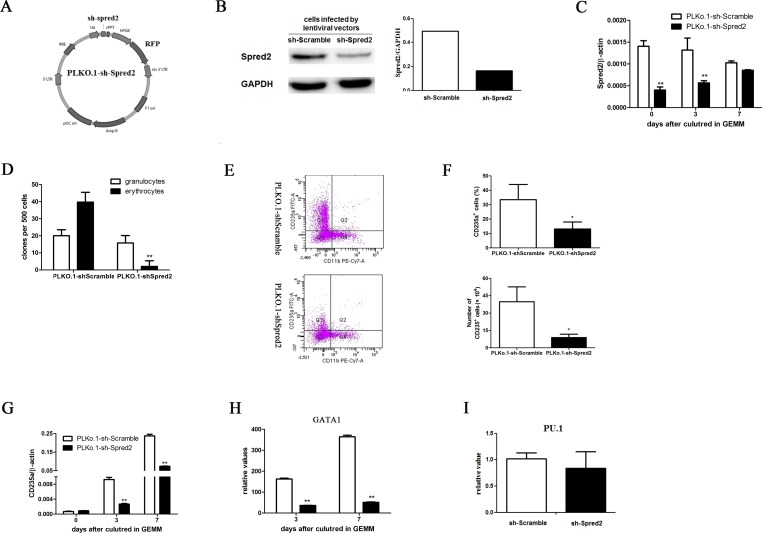
Spred2 interference suppressed the eryhtroid differentiation of human normal bone marrow (NBM) CD34+ cells.The scheme of lentivirus vector with shRNA specifically targeting Spred2, PLKO.1-shSpred2, was shown in A. 48h after transduced with 5 multiplicity of infection (MOI) PLKO.1-shSpred2 or PLKO.1-shScramble, the expression of Spred2 was detected to confirm the interference efficiency by Western-blotting (B) in human NBM CD34+ cells. Human NBM CD34+ cells were infected by PLKO.1-sh-Scramble or PLKO.1-sh-Spred2 at a MOI of 10 and cultured in GEMM medium. At day 0, 3 and 7 post-infection, the expression Spred2 was confirmed by real-time PCR (C), and the expression of CD34, CD235a and CD11b were analyzed by flow cytometer (E-F). Furthermore, the mRNA expression of CD235a (G), GATA1 (H) and PU.1 were detected by real-time RT-PCR. The expression of GATA1 expression was normalized by the expression level at day 0. And, the PU.1 expression at day 3 post-infection was normalized by the expression in PLKO.1-sh-Scramble group (I). PLKO.1-sh-Scramble or PLKO.1-sh-Spred2 transduced CD34+ cells were plated in 24-well plateand cultured in GEMM medium plus 1% methylcellulose for 14 days the presence of colonies (>40 cells) was counted and scored (D). Data are mean±s.d. of three independent experiments. *, p<0.05; **, p<0.01 vs the PLKO.1-sh-Scramble group at the same time point.